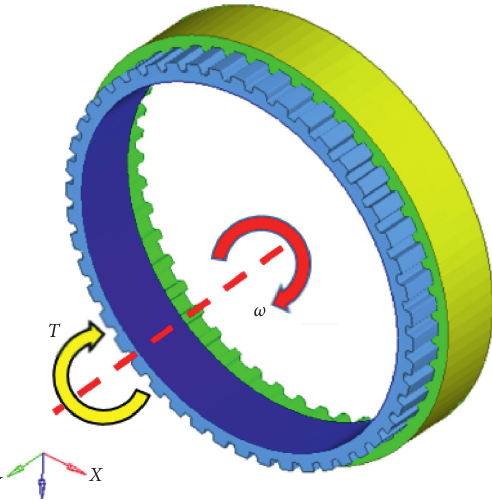
Figure 5: The loading method for wheel-axle spline.